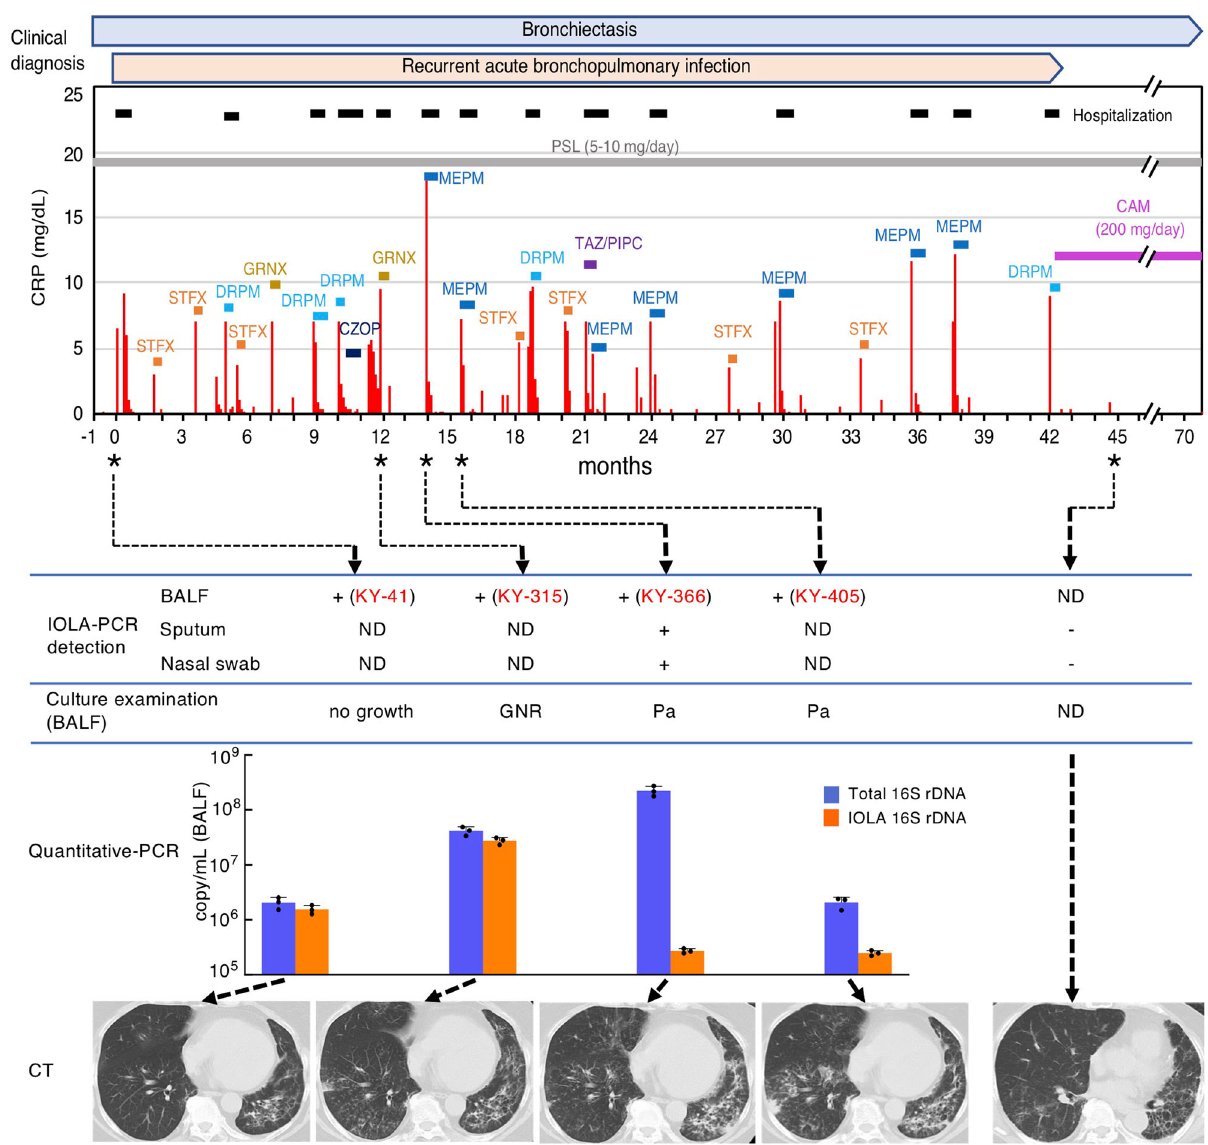
Fig. 7 Clinical course of a patient with long-term persistence of IOLA. From the sampling date of KY-41, the clinical history of a patient who yielded four IOLA-positive BALF samples is shown. Black bars at the top represent the periods of hospitalization. Colored bars indicate the durations of antibiotic treatments. Asterisks indicate the dates of BALF specimen sampling. The results of IOLA-speci fi c PCR detection, quantitative PCR analyses, and routine culture examination of BALF, sputum, and nasal swab specimens are presented under the clinical course. Total bacterial rDNA and IOLA 16 S rDNA were quanti fi ed by quantitative PCR. CT images of the patient ’ s lower bilateral lobes obtained on each sampling day are also shown. PSL prednisolone (corticosteroid), STFX: sita fl oxacin, GRNX garenoxacin, DRPM doripenem, CZOP cefozopran, MEPM meropenem, TAZ/PIPC tazobactam/piperacillin, CAM clarithromycin. + PCR positive, − PCR negative. ND not done, GNR Gram-negative rod, Pa P. aeruginosa